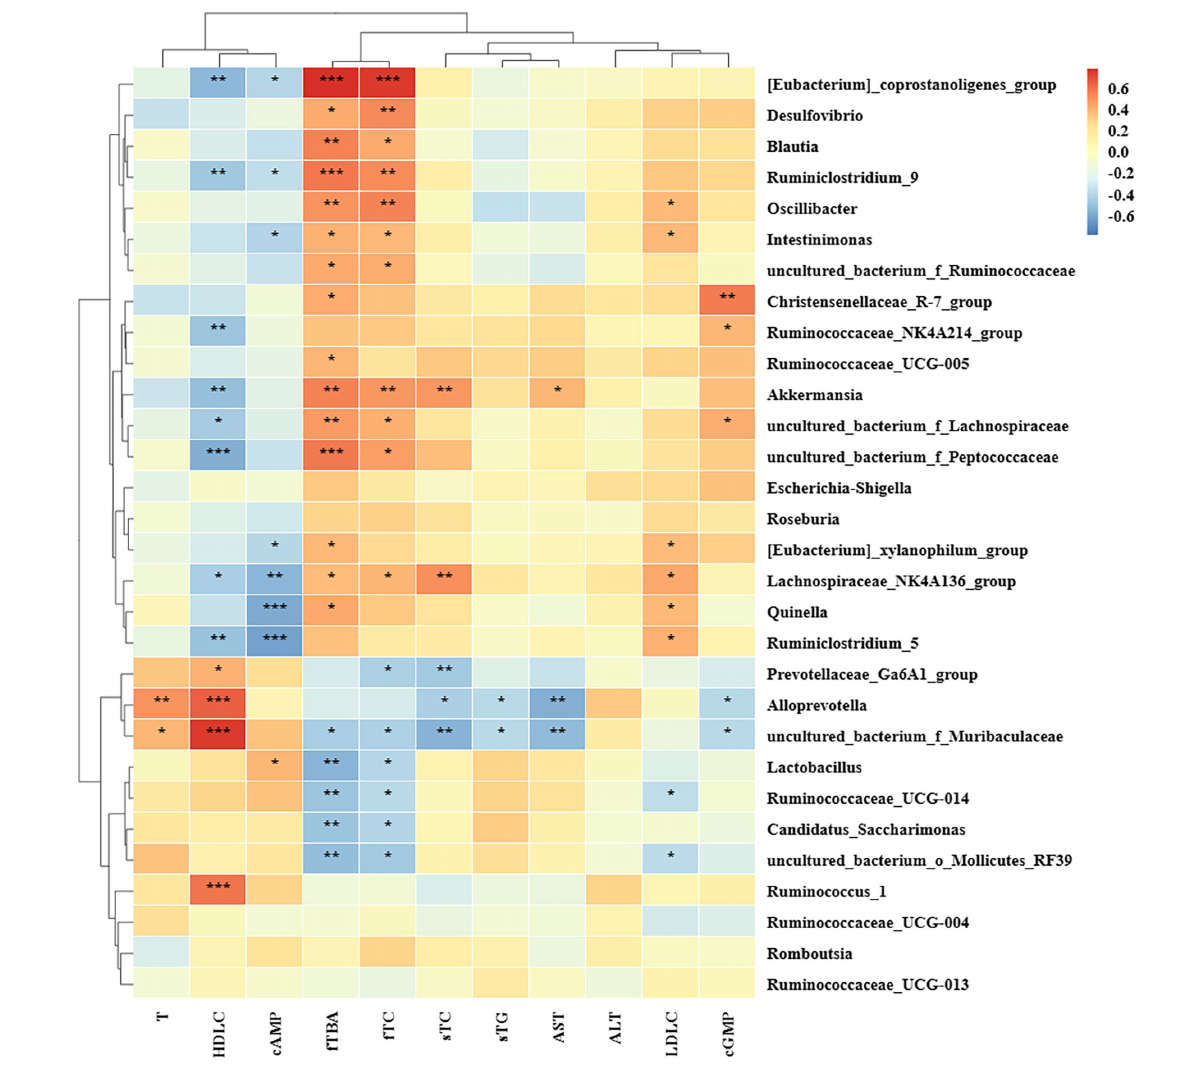
FIGURE 8 Correlation analysis between biochemical indiex and intestinal microbiota based on the Spearman’s analysis. sTC and sTG standed for serum TC and serum TG, respectively. fTC and fTBA standed for fecal TC and fecal TBA,